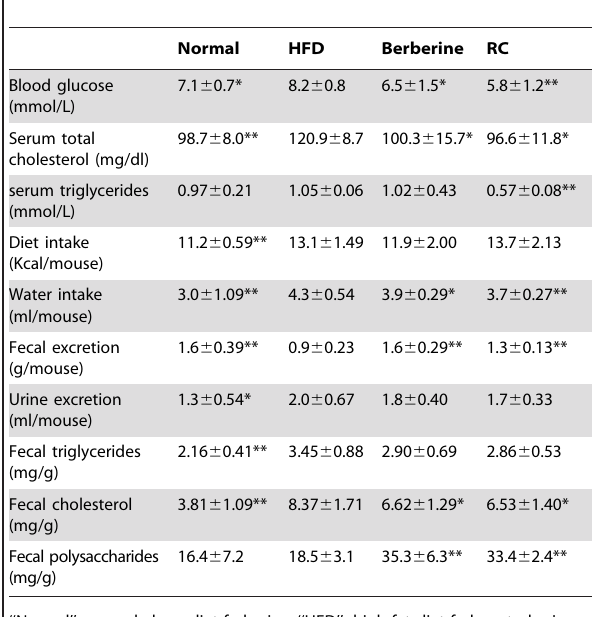
Table 1. Effects of RC and berberine on blood biochemical assay parameters, metabolic cage trials, and fecal lipid and polysaccharide evaluations in HFD